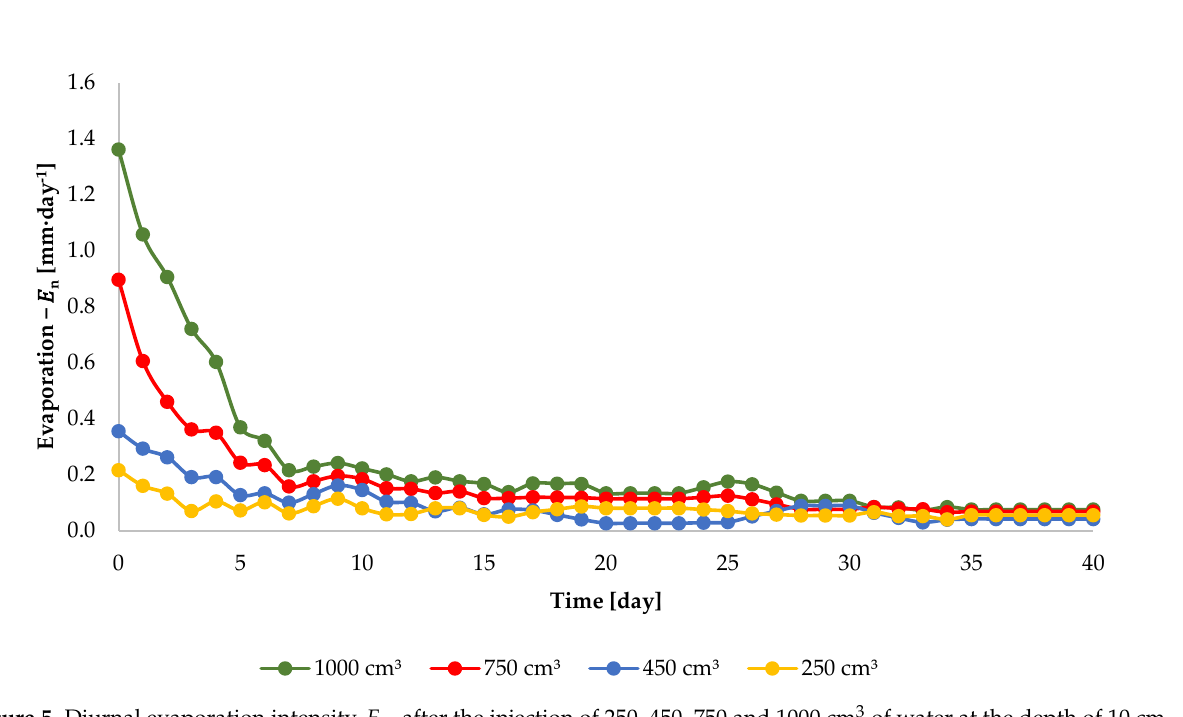
𝐸𝐸 𝑛𝑛 The diurnal values of evaporation intensity calculated on the basis of Equation (1) for